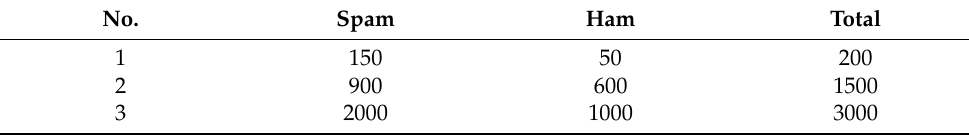
Table 3. Implemented most common words ratios